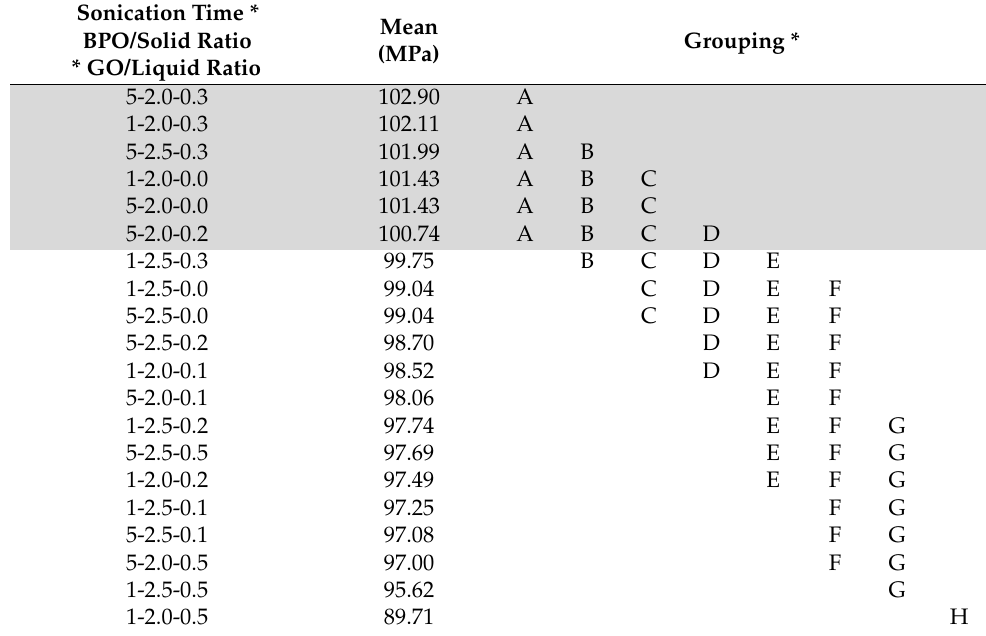
Table 4. Grouping information for compressive strength using Tukey’s test and 95% confidence.